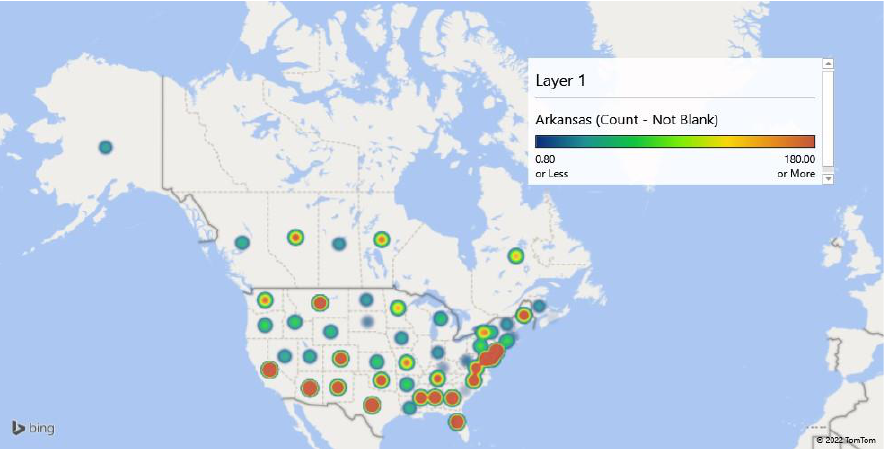
Figure 3. Distribution map of pavement rehabilitation projects